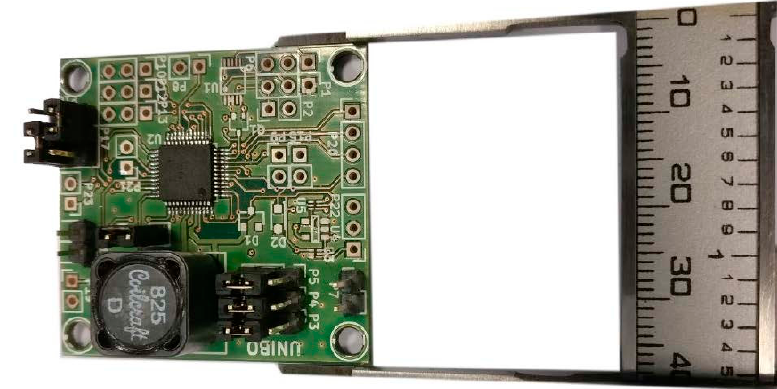
Figure 8. Harvesting module board.